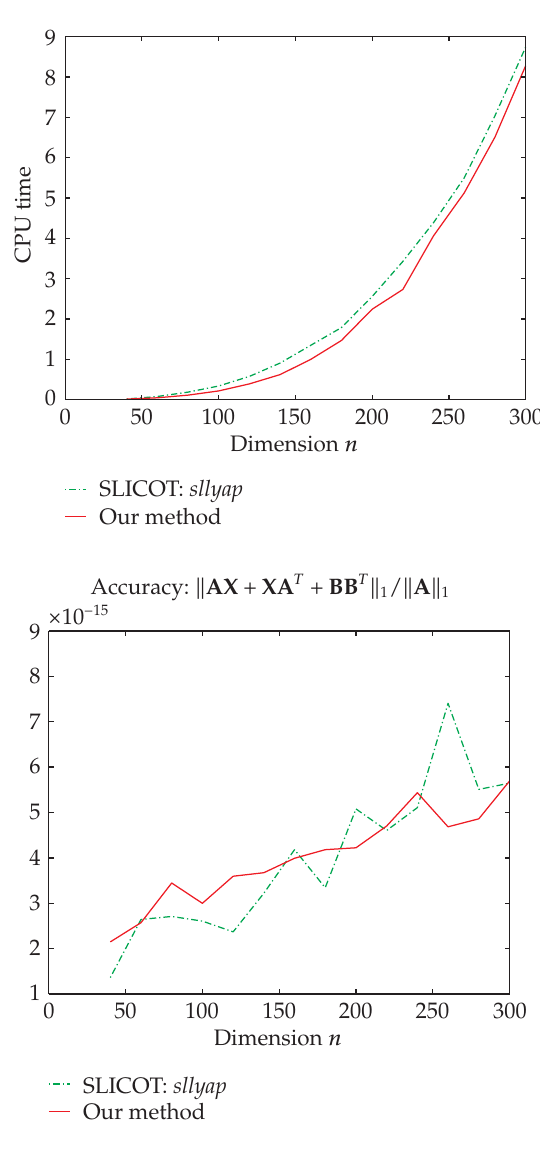
Figure 3.3 . Performance comparison: lyapUR versus sllyap